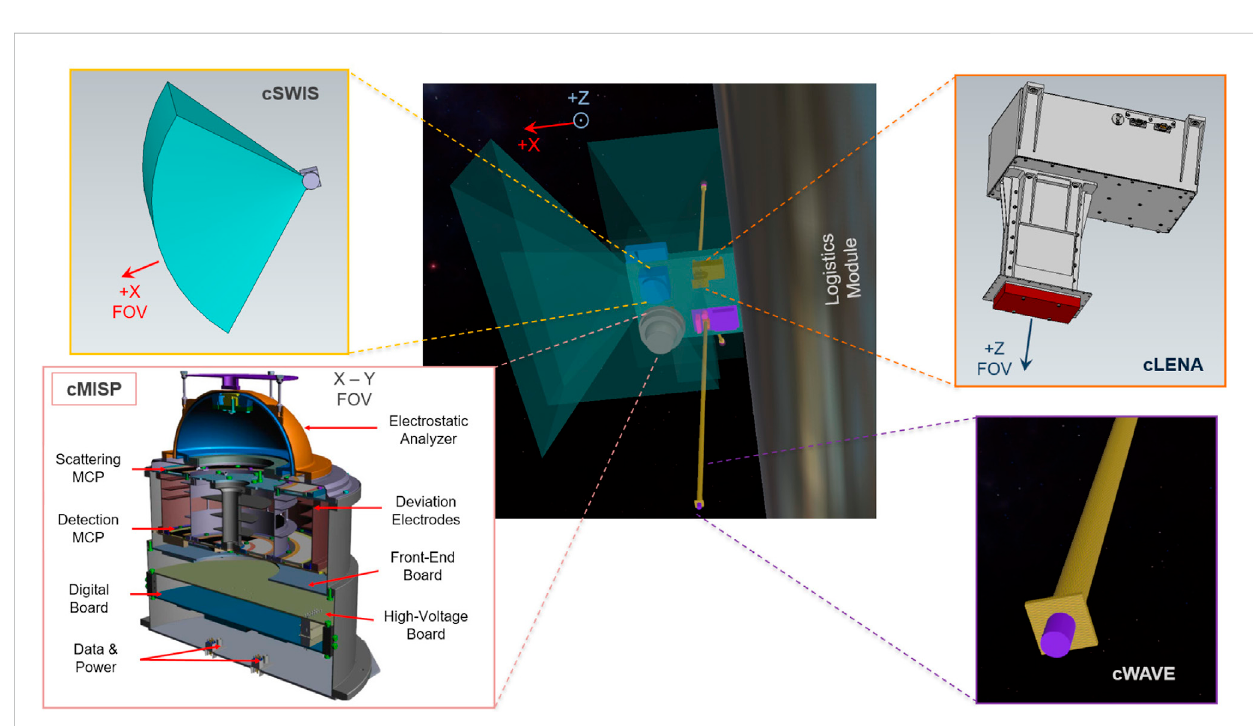
FIGURE 19 MainInstrumentPlatform+Zside.TheturquoisesolidangleinthecSWISinstrumentinset(upperleft)representstheinstrument fi